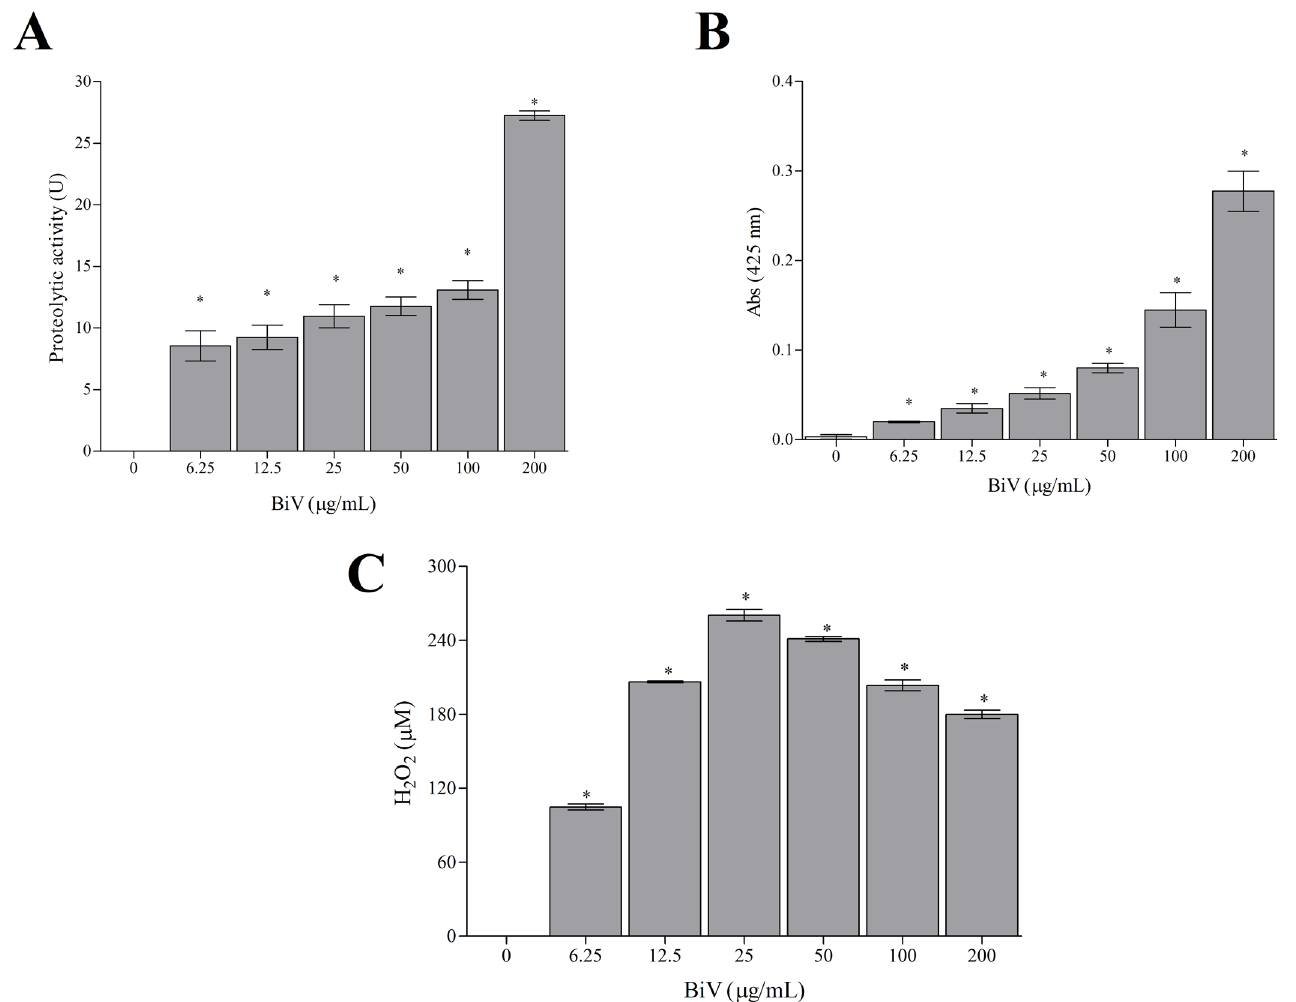
Fig 1. Enzymatic activities exhibited by BiV. [A] Proteolytic activity, assessed by azocasein cleavage method; [B] phospholipasic assay, determined using 4N3OBA as the lipidic substrate; and [C] H 2 O 2 production induced by BiV, suggestive of the presence of LAAO. * p < 0.05 vs control group (absence of